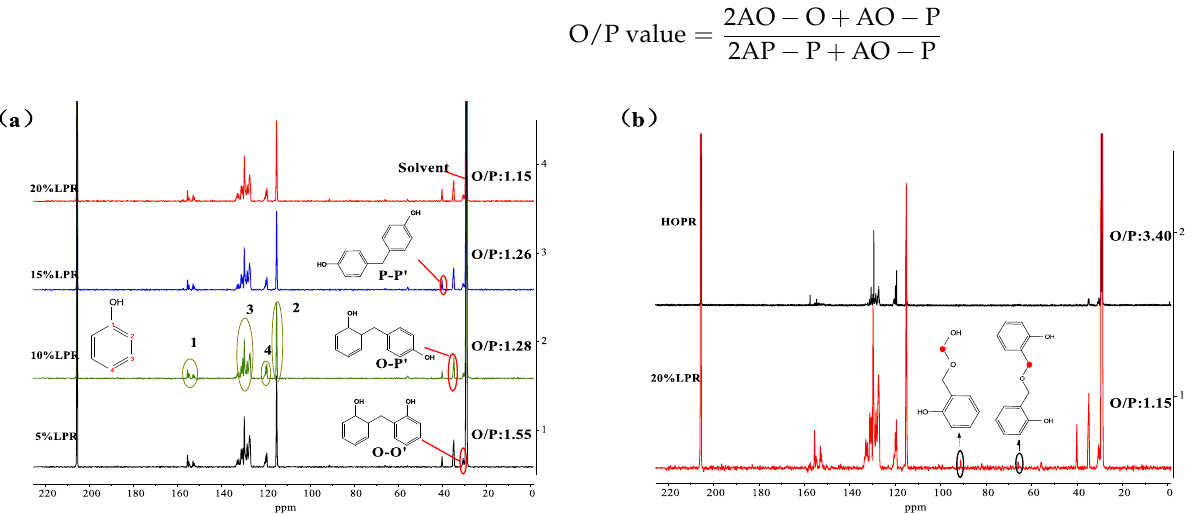
Figure 2. ( a ) The 13 C-NMR spectra of LPRs with different lignin replacement amounts (5–20%); ( b ) difference of 13 C-NMR spectra of lignin before and after the resin reaction (20% LPR and HOPR).